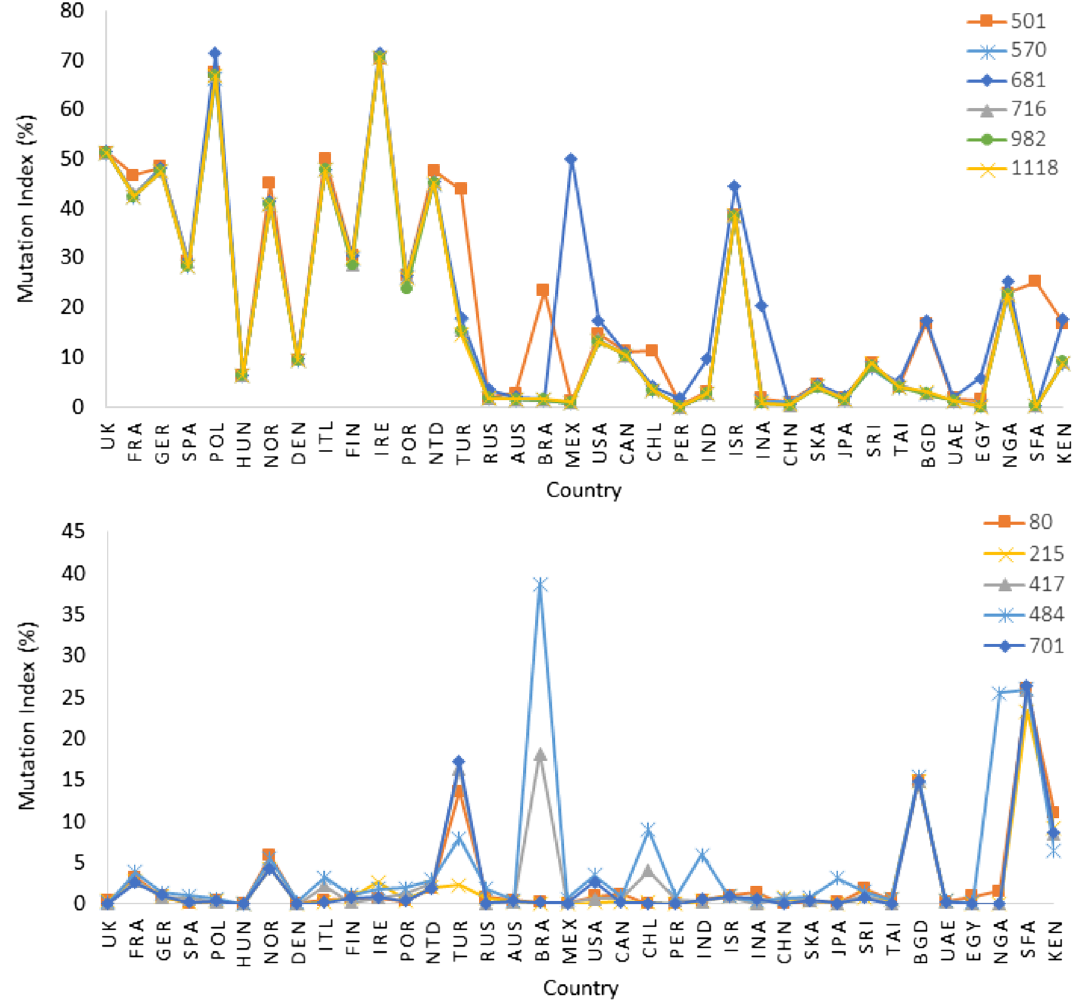
Figure 3. Profile of discrete mutations frequency across different countries as found in ( a ) amino acids in cluster 4 and ( b ) cluster 6, of Fig.